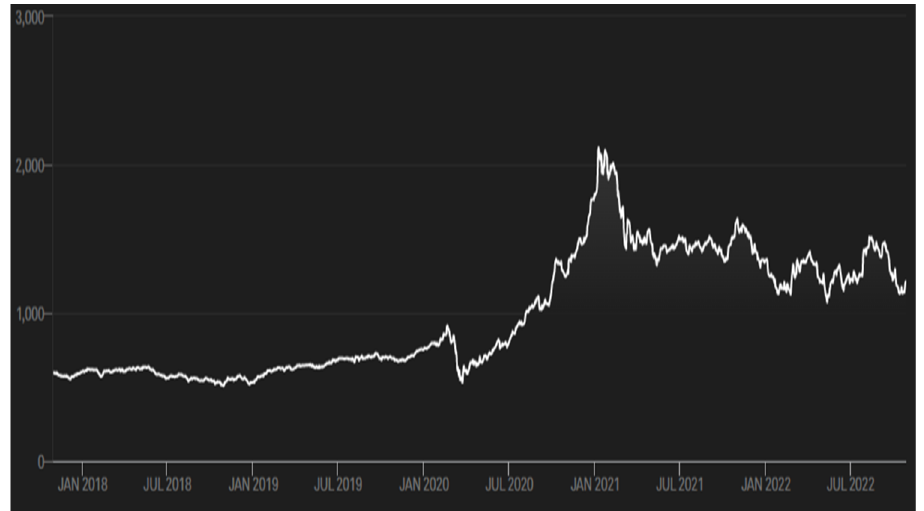
Figure 4. S&P Global Clean Energy Index: five-year quotes. Source: [79].